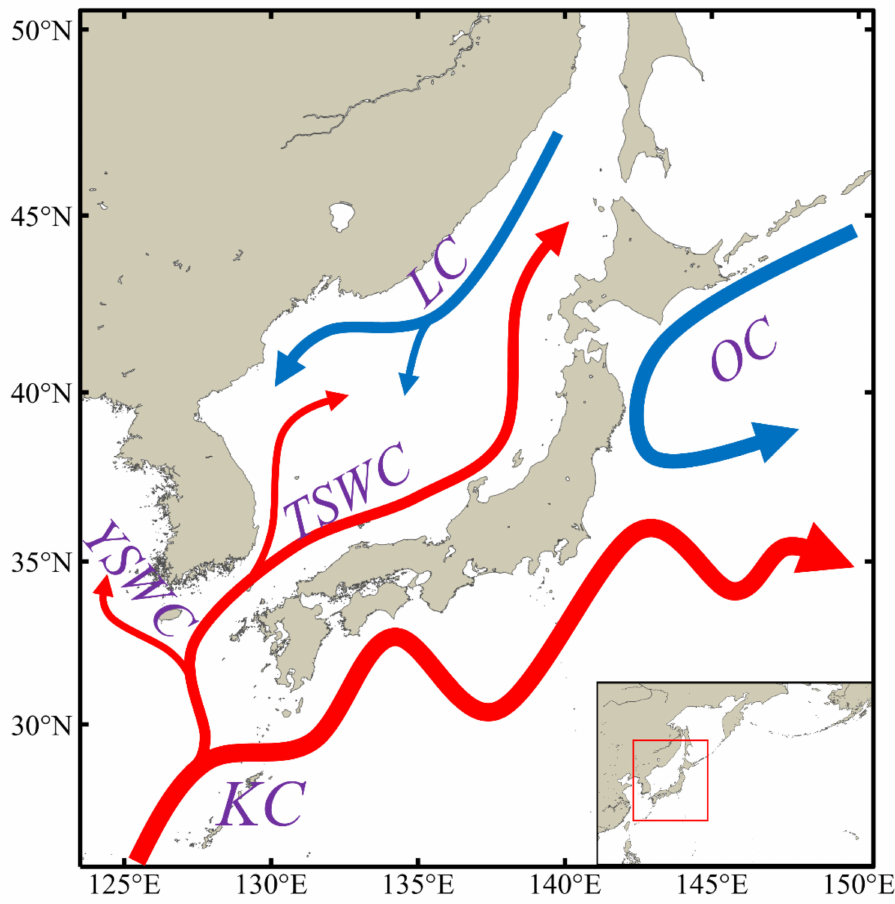
Figure 1. Map of the research area. Red and blue lines indicate primary warm and cold currents in temperate waters of the northwestern North Pacific, including the Kuroshio Current (KC), Yellow Sea Warm Current (YSWC), Tsushima Warm Current (TSWC), Oyashio Current (OC), and Liman Current (LC). The panel at the bottom right shows the location of the research areas in the North